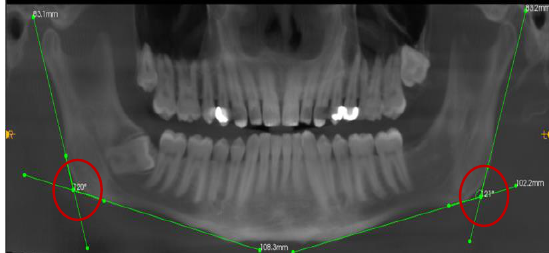
Figure 4: Measurement of gonial angle on left and right